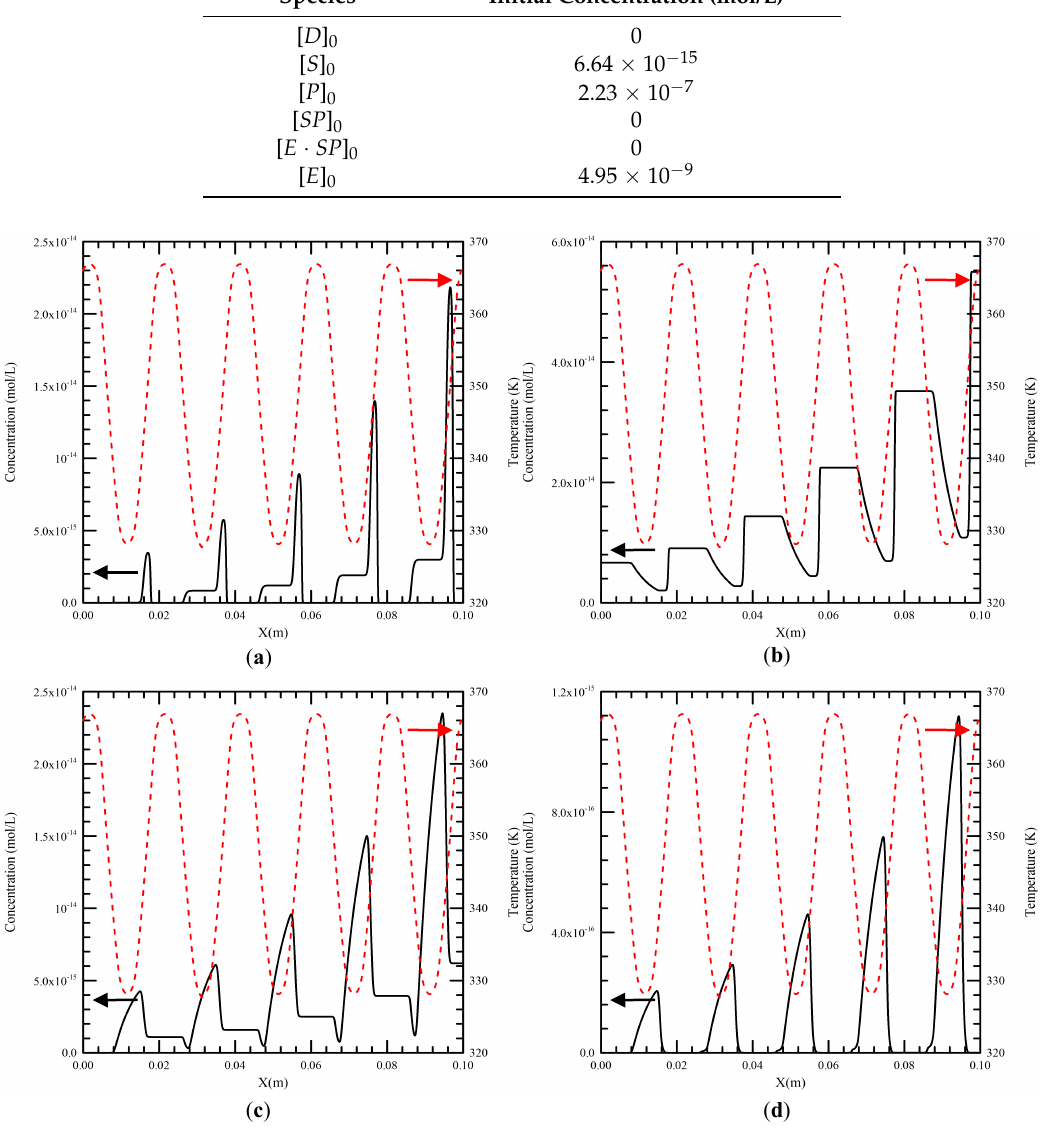
Figure 8. The concentration profiles of ( a ) double-stranded DNA molecules, ( b ) single-stranded DNA molecules, ( c ) single-stranded template–primer complexes and ( d ) single-stranded template–primer–enzyme complexes (i.e., [ D ], [ S ], [ SP ] and [ E·SP ]) along the central line of the channel. Table 2. Initial concentrations of the species of the polymerase chain reaction (PCR) mixture.